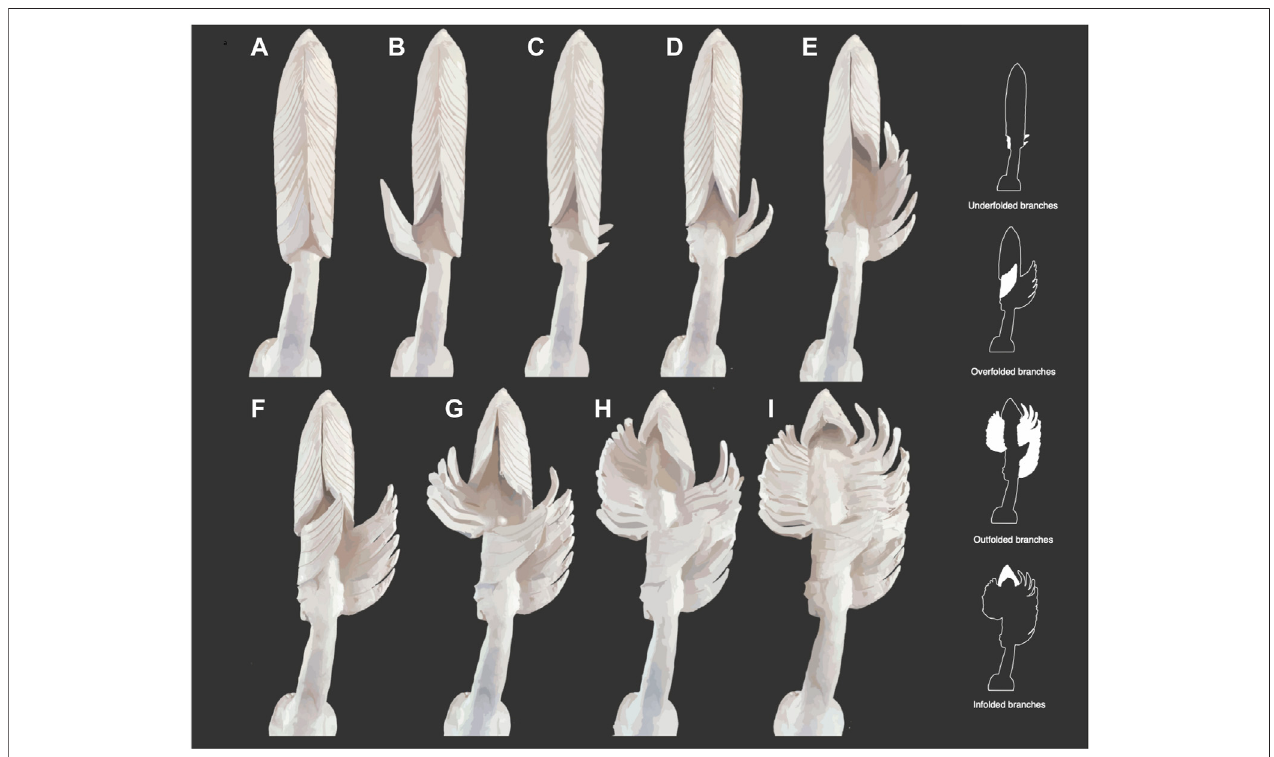
FIGURE 5 | Taphonomic stop-motion model of the holotype of C. concentricus showing different branch folding. (A – C) underfolding of proximal-most branches. (A – I) infolding of distal-most branches. (D – I) outfolding of bottom-right and central branches. (F – I) overfolding of bottom-left branches.